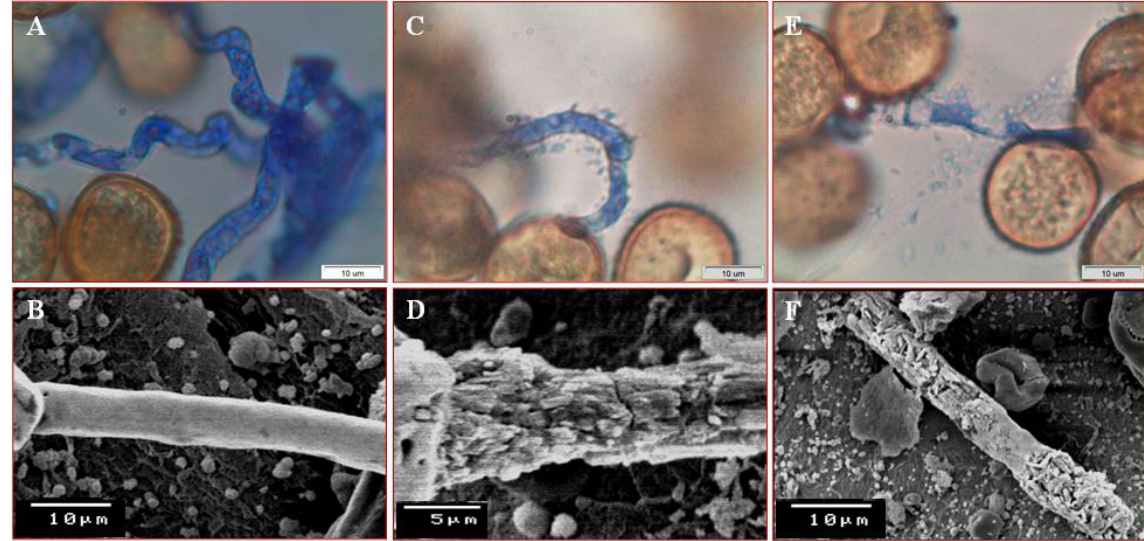
Figure 3. Light and scanning electron micrographs showing the inhibitory impact of Pseudomonas putida strain ASU15on uredospores of Uromyces appendiculatus. ( A , B ) Normal germinating uredospores (control) showing vigor germ tube; ( C , D ) P. putida cells attack the germ tube; ( E , F ) Degradation of cell wall of the germ tube by mycoparasitic activity of P. putida and then release of the cytoplasmic contents from a ruptured germ tube.